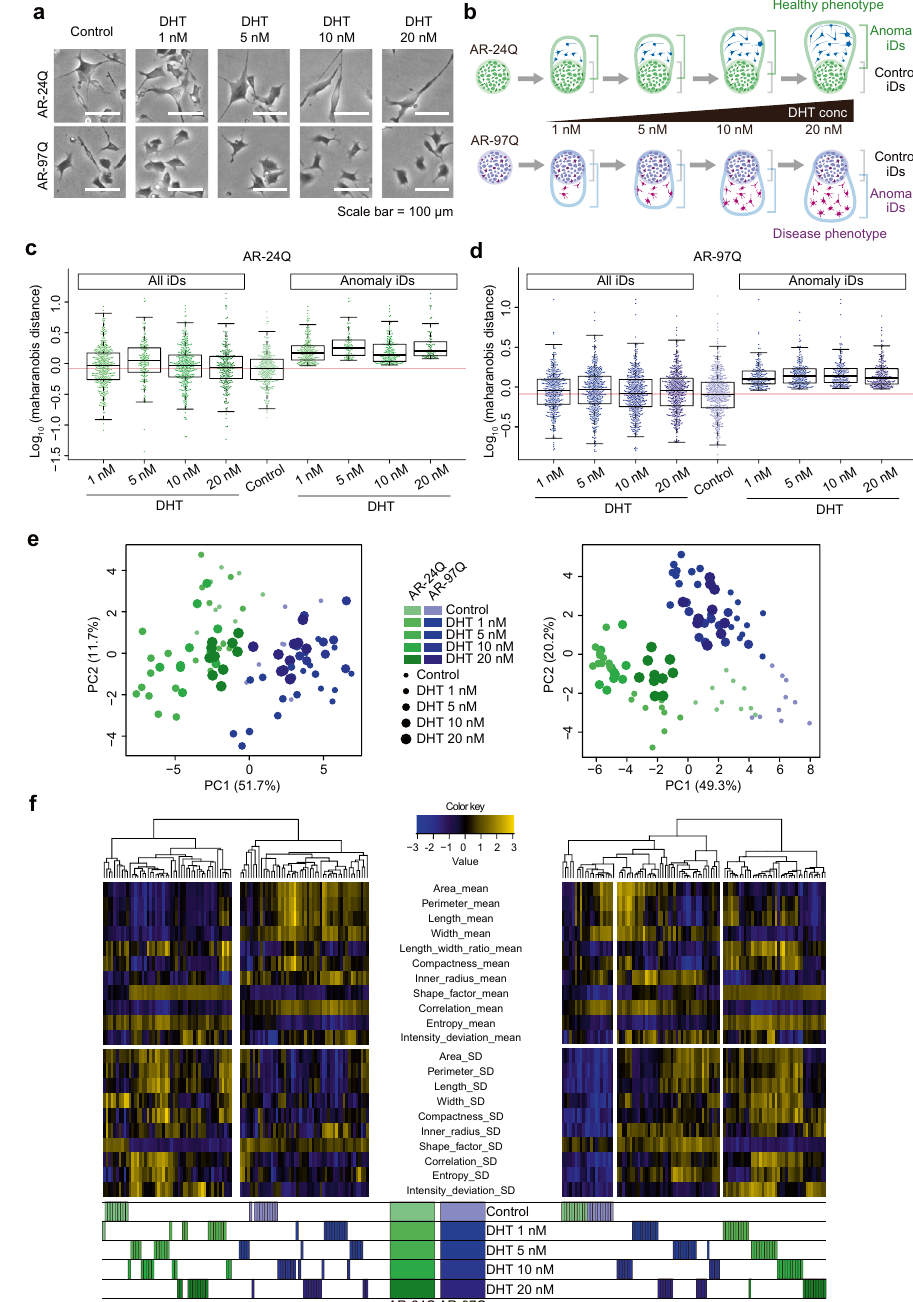
Figure 3. Evaluation of phenotypic responses of model cells to dihydrotestosterone (DHT). ( a ) Representative images depicting the effect of DHT on model cells. ( b ) Schematic illustration of in silico featured-objects concentrated by anomaly discrimination from unit space (in silico FOCUS) analysis used to compare the phenotypic response of model cells to DHT. ( c , d ) Distribution of Mahalanobis distances of individual data (iDs) (all iDs, control, and anomaly iDs from in silico FOCUS) from the centroid of the unit space defined by control iDs. Box plot (median at the center, and the 25 and 75 percentiles at the end) with whiskers (standard deviation) overlaid on the beeswarm plot. The red line indicates the mean of control iDs. ( e , f ) Principal component analysis (PCA) and clustering of population data (pD) with bootstrap (b-pDs) (left) and pDs from in silico FOCUS (focused pDs) (right). All illustrations created by Adobe Illustrator 24.1.1 (https:// www. adobe. com/ jp/ produ cts/ illus trator.